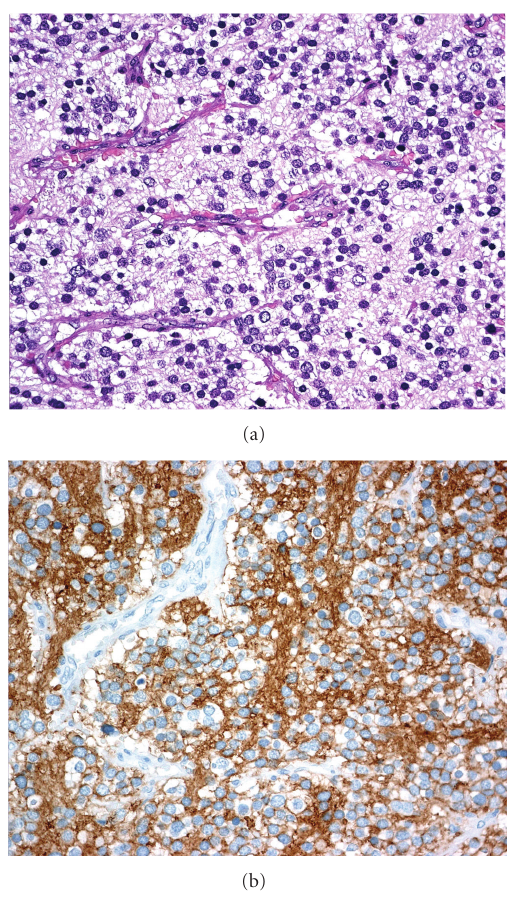
Figure 2: (a) The tumor shows a lobular architecture made of small uniform cells, with indistinct cell borders, hyperchromatic nuclei, fibrillary matrix material, and scattered large cells with eosinophilic cytoplasm. (b) The tumor is strongly positive for NSE